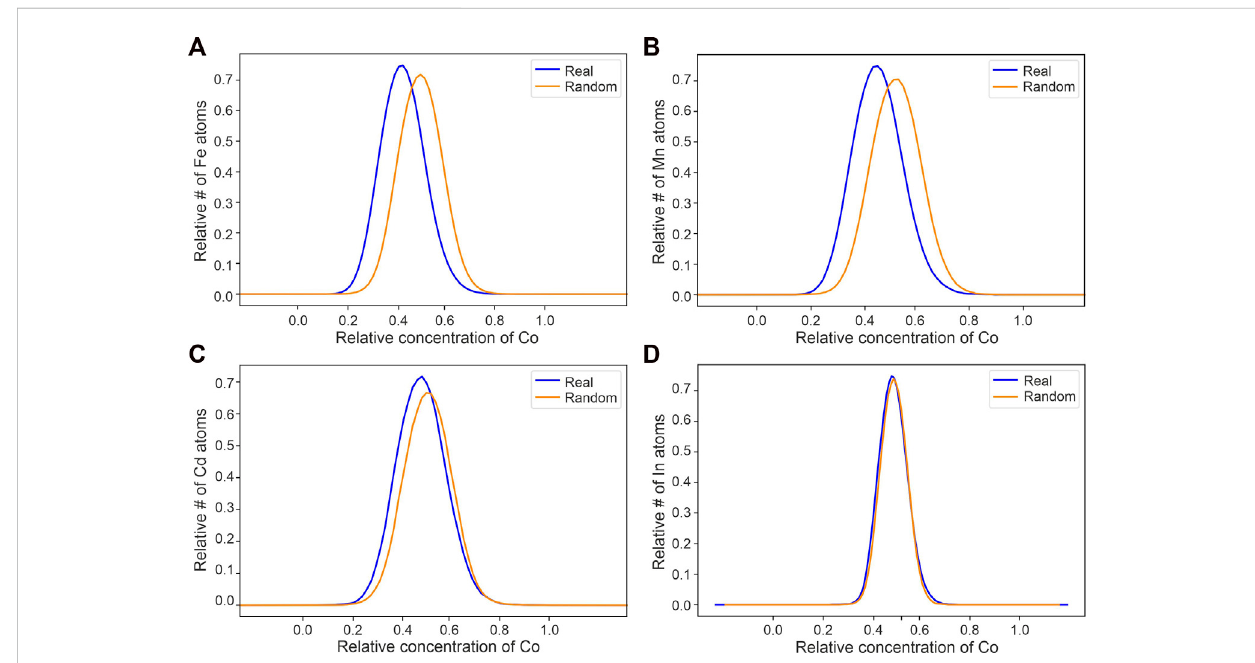
FIGURE 7 LocalconcentrationofCosurroundingeachFe,Mn,Cd,andInions[ (A – D) respectively]. Y -axis showstherelativenumberofFe,Mn,Cd,and Inions that are surrounded by a relative concentration of